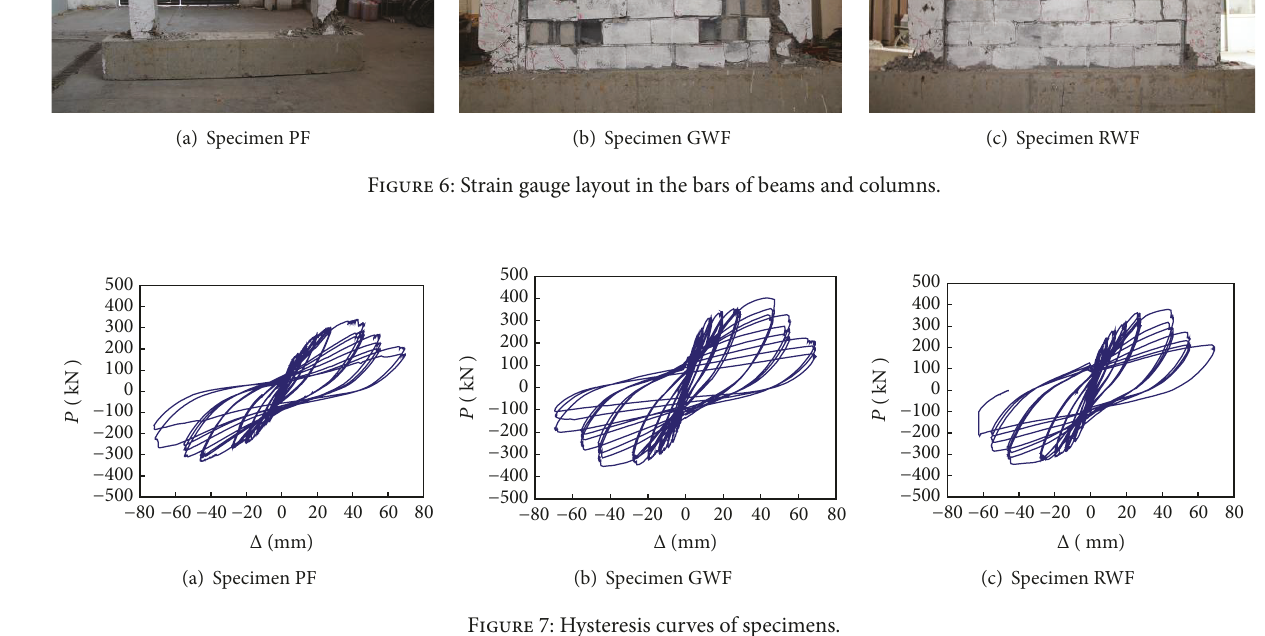
Figure 7: Hysteresis curves of specimens.